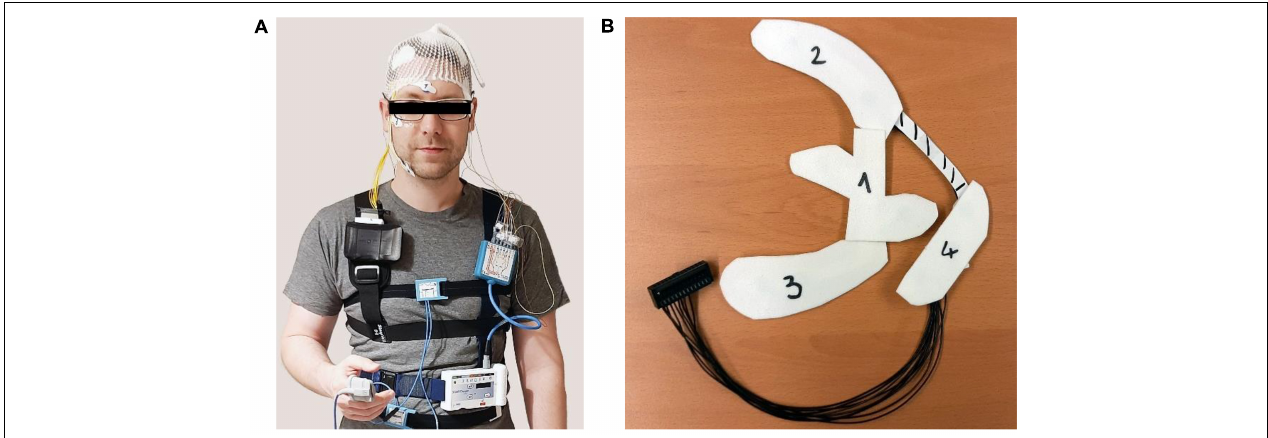
FIGURE 2 | (A) Recording setup of the validation study including the commercial at-home PSG system and the trEEGrid system worn at the same time. (B) View on foam electrode grid prepared for self-application with wax paper covers in place to guide the participant through application.